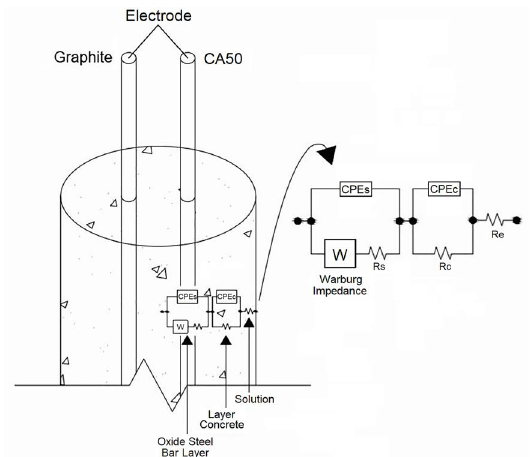
Table 4. The resistance R, constant phase element CPE and admittance Y 3, 7 and 28 days Cycle Curing time R kΩ.cm e